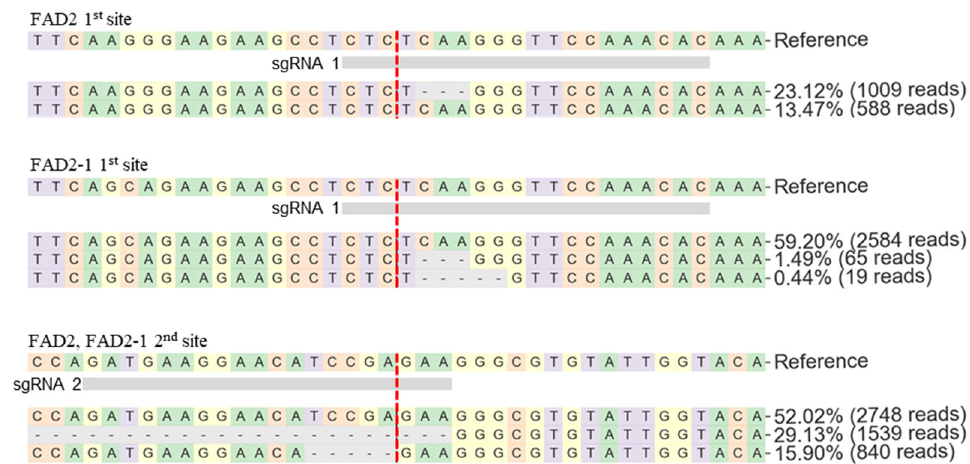
Figure 9. Target sequence alignment of pHEE401E_4sg-10 FAD2 and FAD2-1 . Vertical red dash indicates predicted cleavage site.